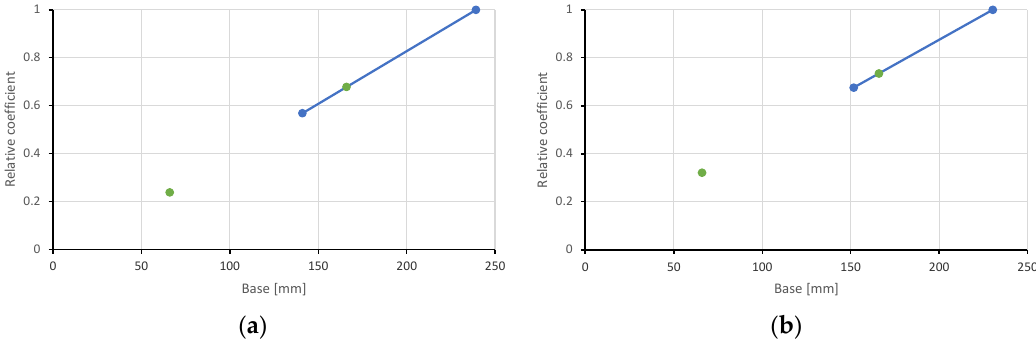
Figure 17. Relative coefficients for the prediction of the depth of the neutral axis in section II-II and III-III; ( a ) slab 1; ( b ) slab 2.